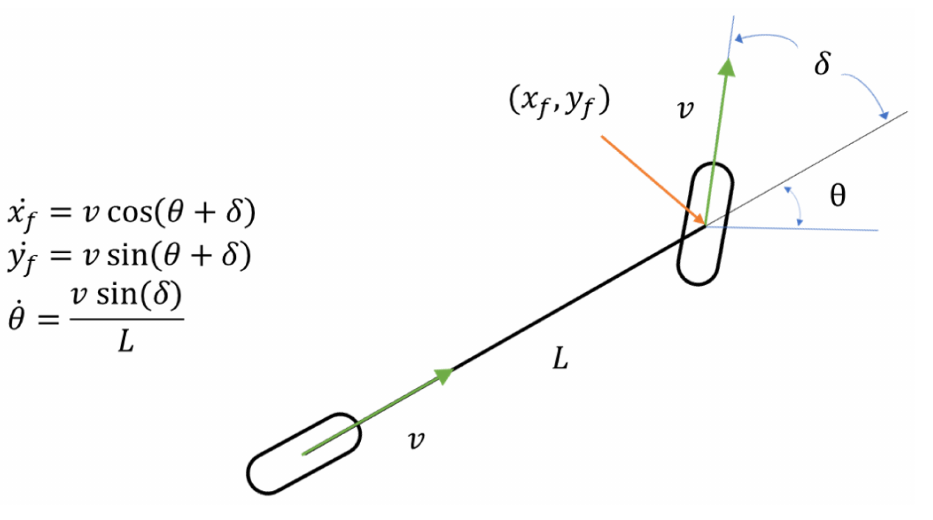
Figure 11. Vehicle